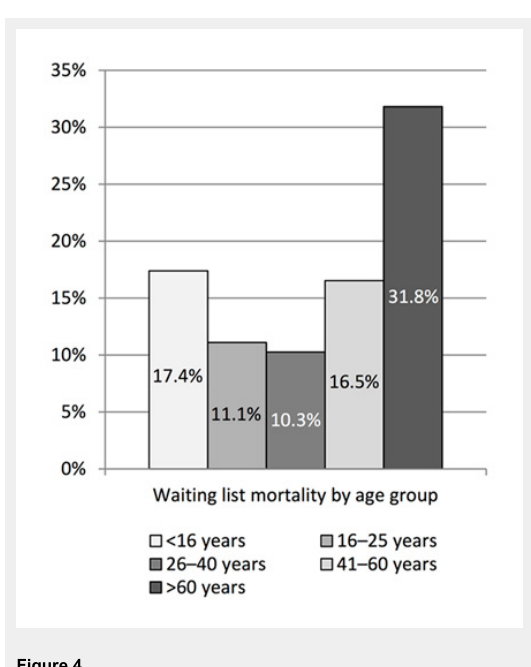
Heart allocation algorithm as implemented in the SOAS. D = donor; MT = multi-organ transplantation; R = recipient